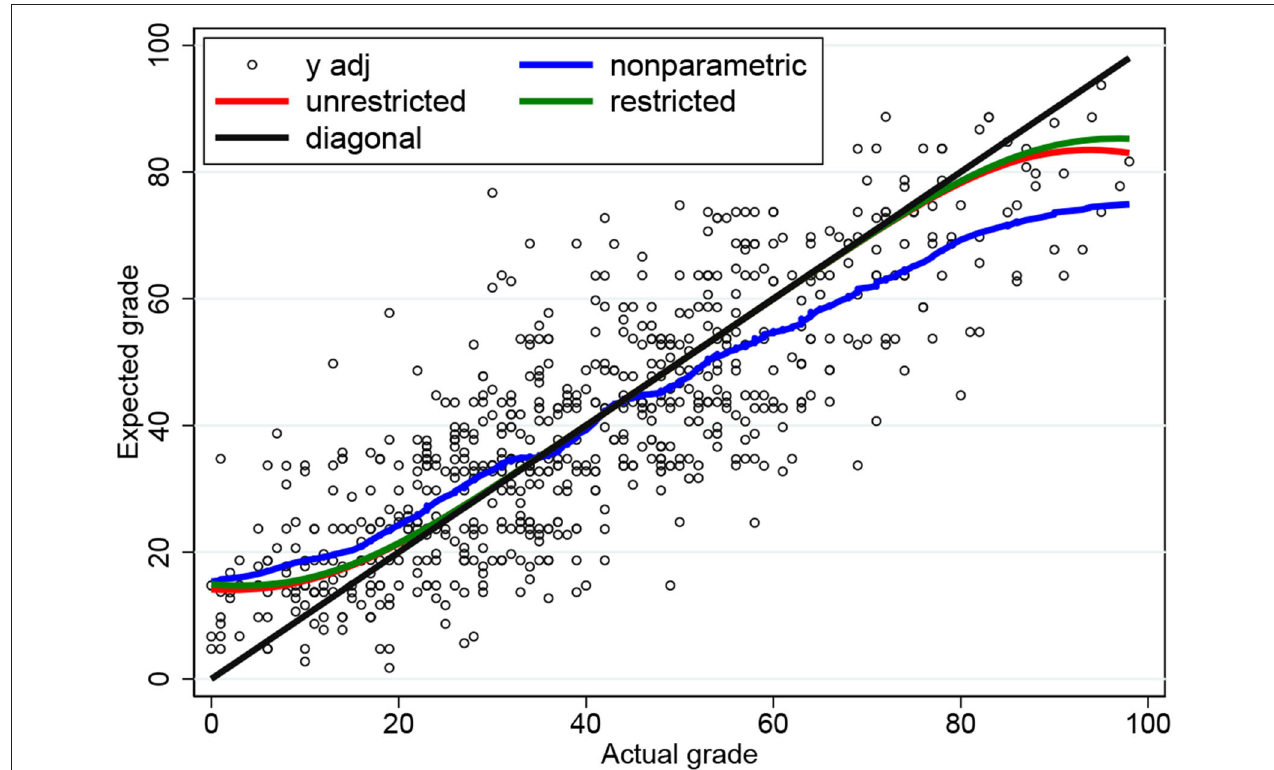
FIGURE 3 | Conditional expectation functions for the three-parameter censored tobit model based on ML and nonparametric estimates.